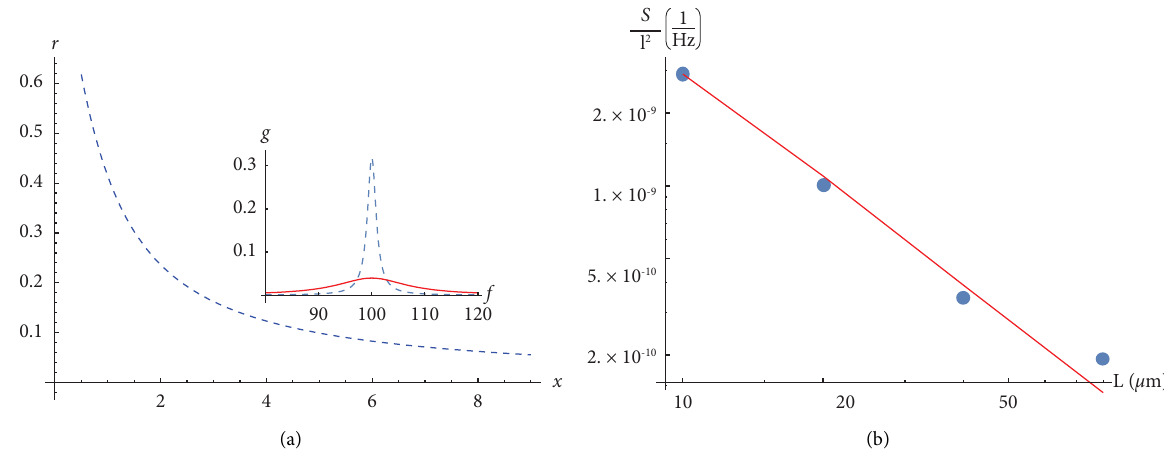
Figure 5: (a) r versus x, displaying decrease in synchrony with x. Inset shows Lorentz distribution for two values of Γ : Γ � 1 (black, dashed), 8 (red, solid) exhibiting increased frequency spread in the latter. (b) Comparison between the consistency analysis and data for a-IGZO shown in Figure 2 for frequency 100Hz